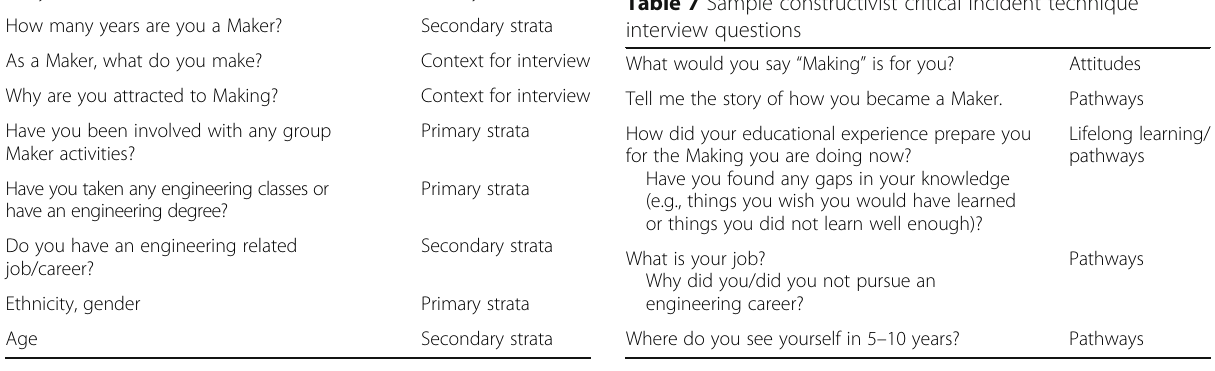
Table 7 Sample constructivist critical incident